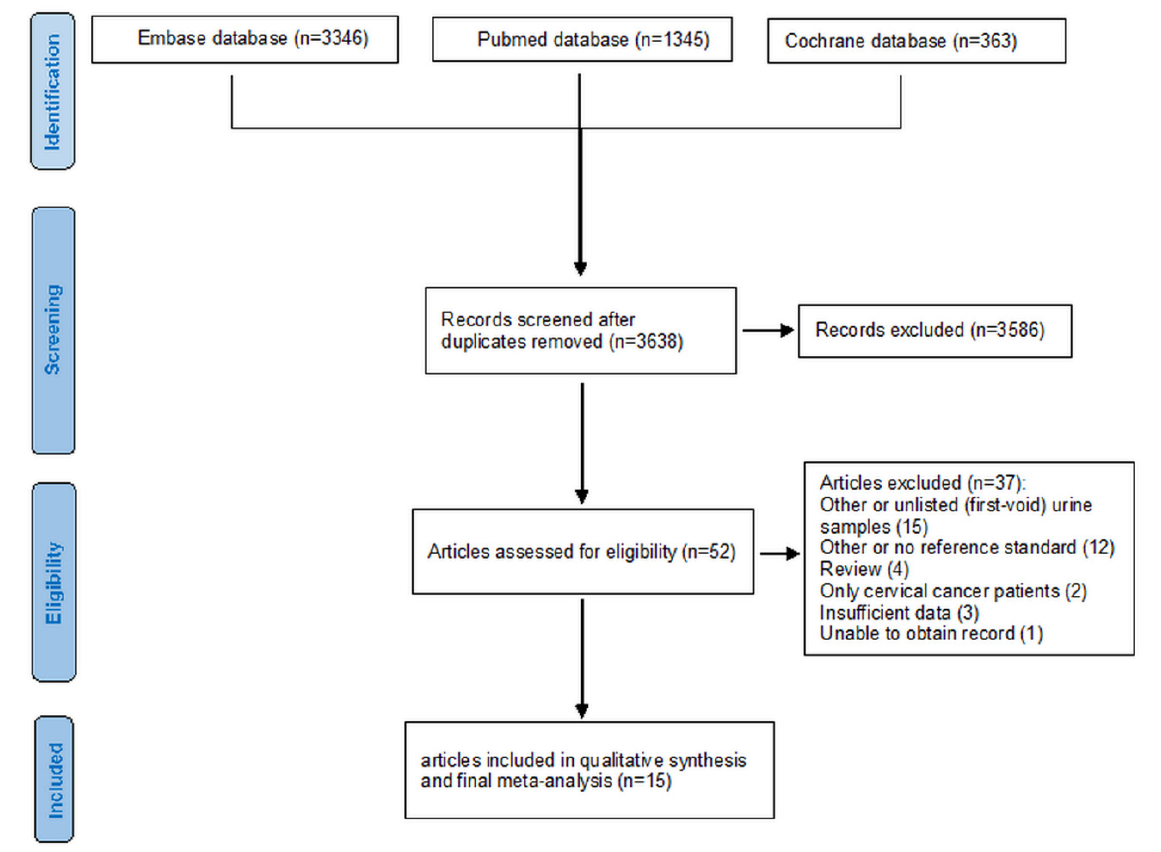
Figure 1 . Flow diagram of the studies selected for this meta-analysis. Figure 1. Flow diagram of the studies selected for this